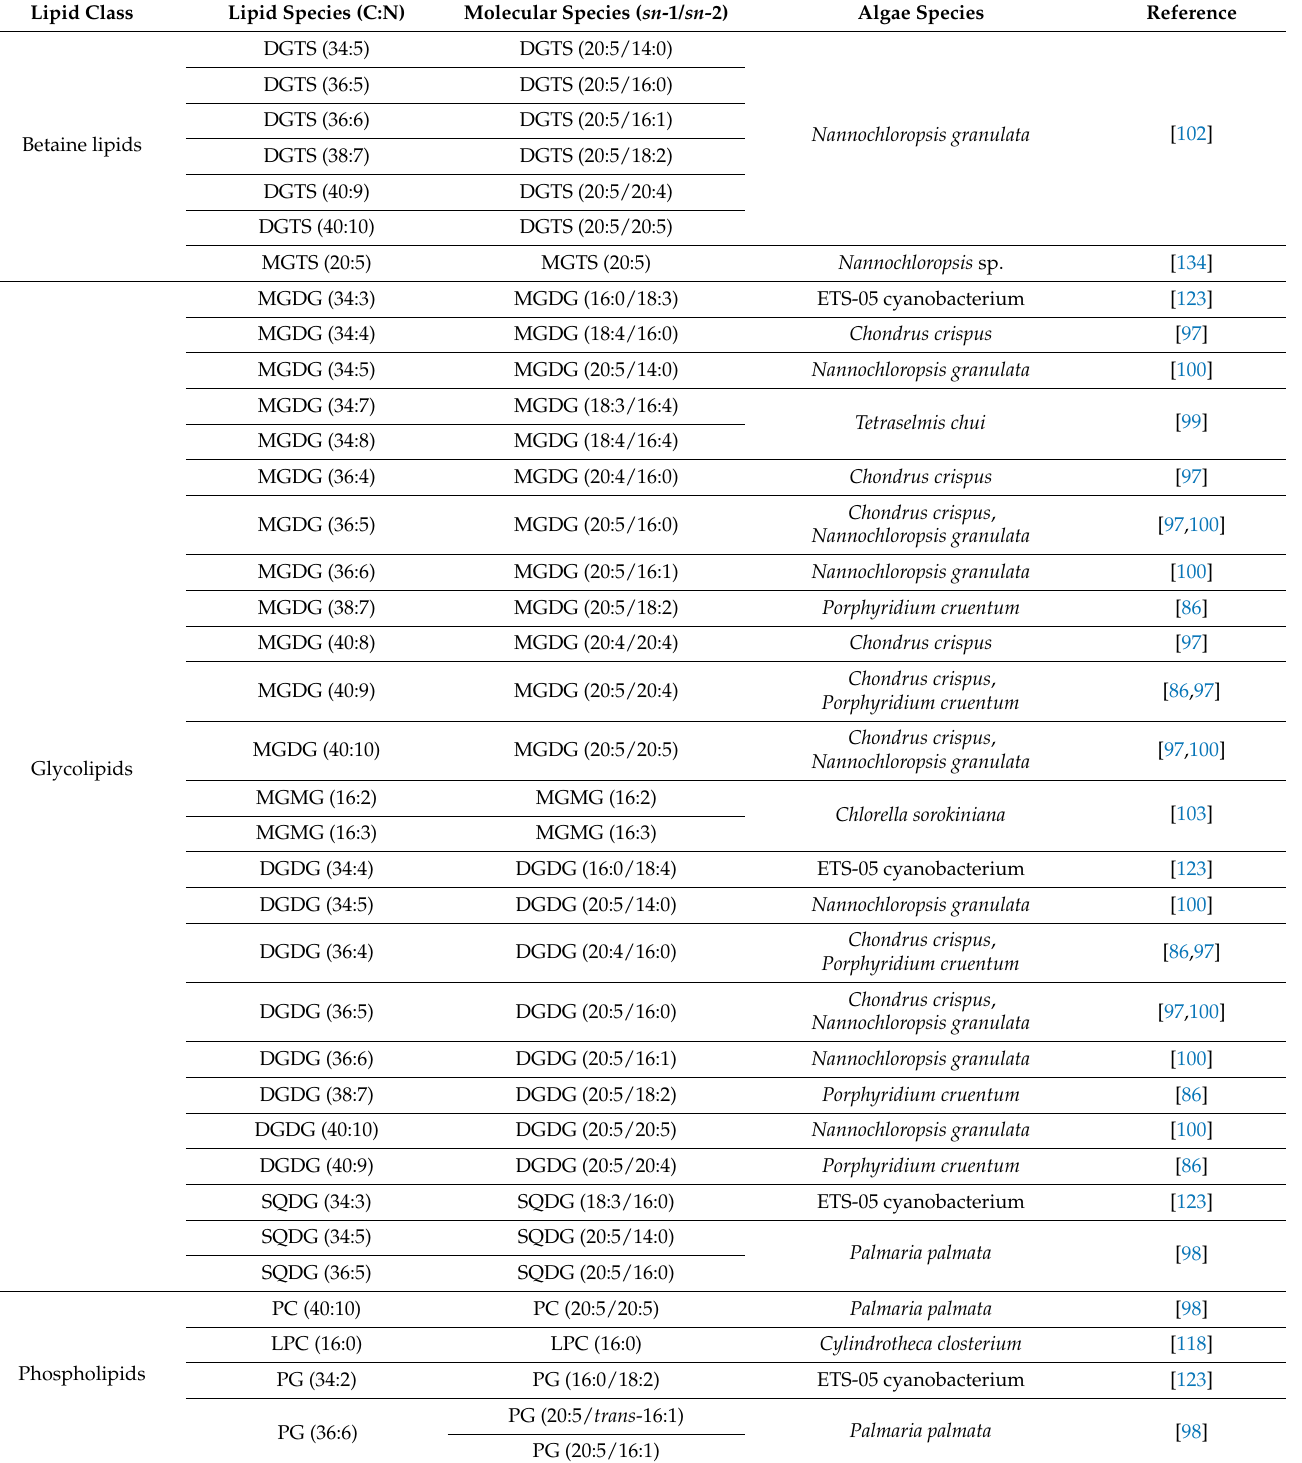
Table 3. Polar lipid species from microalgae and macroalgae with reported anti-inflammatory activity. Ab- breviations: DGTS—diacylglyceryltrimethylhomoserine, MGTS—monoacylglyceryltrimethylhomoserine, MGDG—monogalactosyldiacylglycerol, MGMG—monogalactosylmonoacylglycerol, DGDG— digalactosyldiacylglycerol, SQDG—sulfoquinovosyldiacylglycerol, PC—phosphatidylcholine, LPC— lysophosphatidylcholine, PG—phosphatidylglicerol, C—total number of carbon atoms on fatty acyl chains, N—total number of double bonds on the fatty acyl chains. Algae